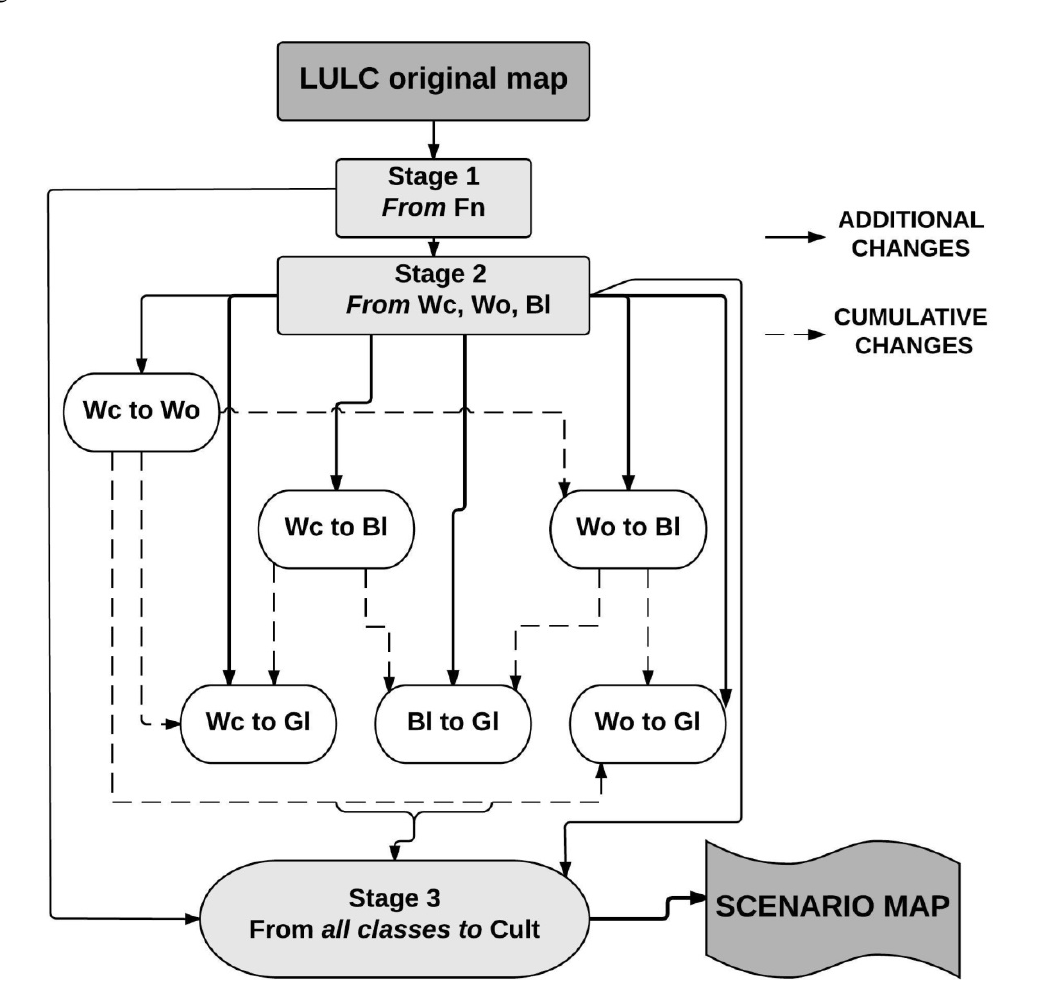
Figure A2.4: Stepwise spatial allocation of land cover changes following land demand and composite indicators of likelihood of change. Symbols: Fn = natural forest (mountain and lowland forest); Wc = closed woodland; Wo = open woodland; Bl = bushland; Gl = grassland; Cult = cultivated